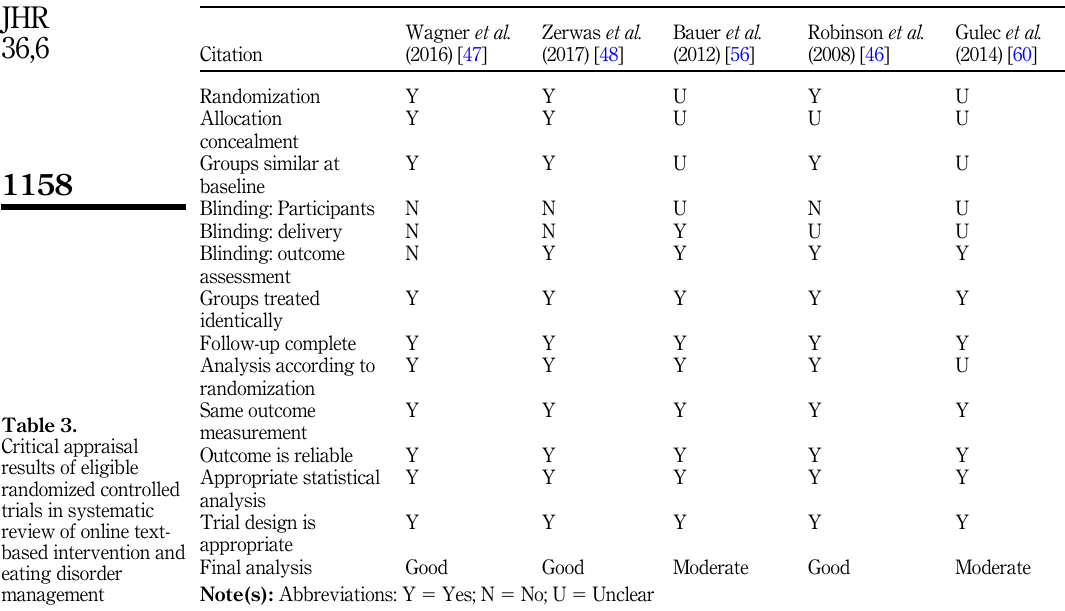
Table 3. Critical appraisal results of eligible randomized controlled trials in systematic review of online text- based intervention and eating disorder